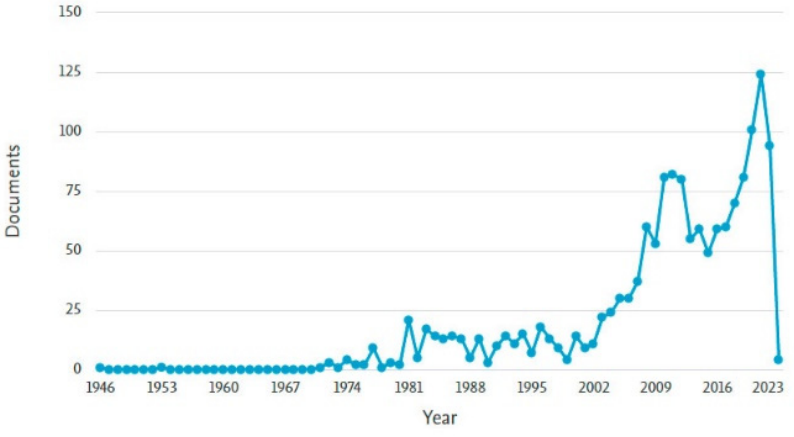
Figure 2. Number of documents published in Scopus-indexed journals per year (Scopus, 2022).